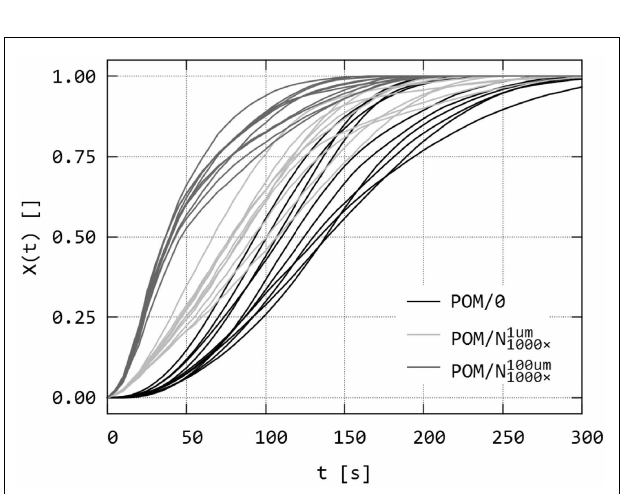
FIGURE 9 | Simulation of isothermal spherulitic crystallization in FIGURE 10 | Simulation of isothermal spherulitic crystallization in sandwich composites with program SCRYST: the second output of the sandwich composites with program SCRYST: the third output of the program – raw data of relative crystallinity, X ( t ), as a function of time . program – averageAvrami fits of all X ( t ) values of all simulated POM The sandwiches POM/0, POM / N 1 µ m and POM / N 100 µ m are the same as in sandwiches .The sandwich composites POM/0, POM / N 1 µ m 1000 × 1000 × are the same as in Figures 8 and 9 POM / N 100 µ m Figure 8 . For each sandwich, 10 simulations were calculated. 1000 ×